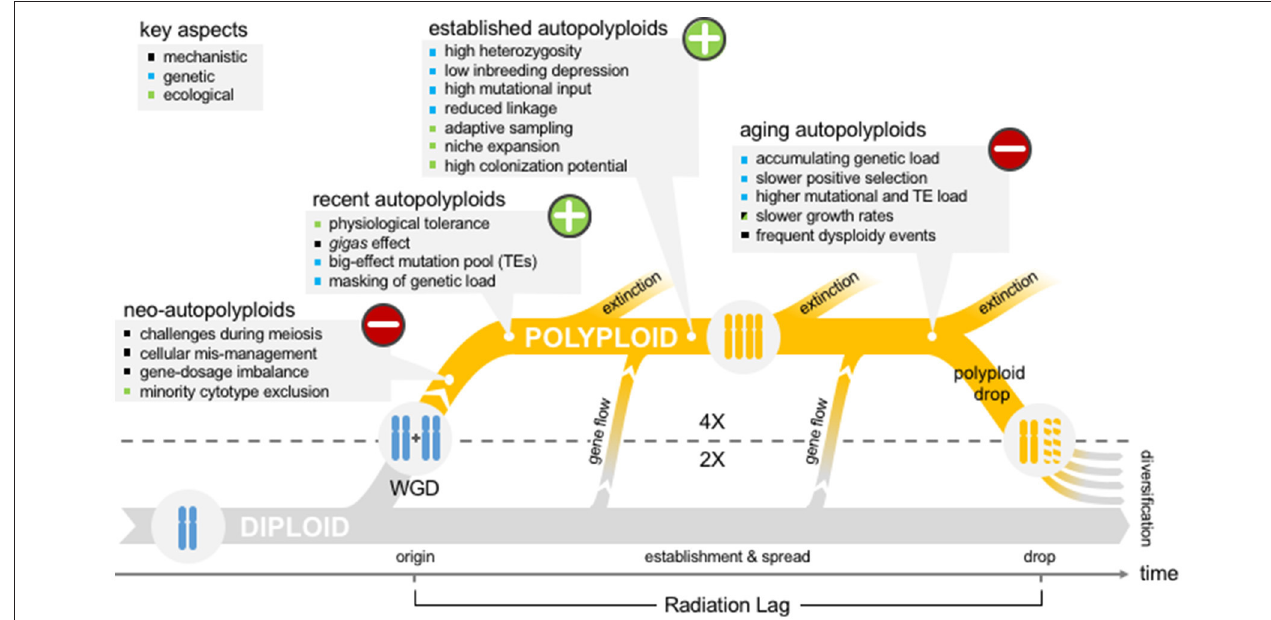
FIGURE 1 | The polyploid hop. Schematic representation of the temporal evolution of a diploid-autopolyploid system accompanied with the shifting benefits and pitfalls linked with WGD and that can contribute to the different stages of polyploid